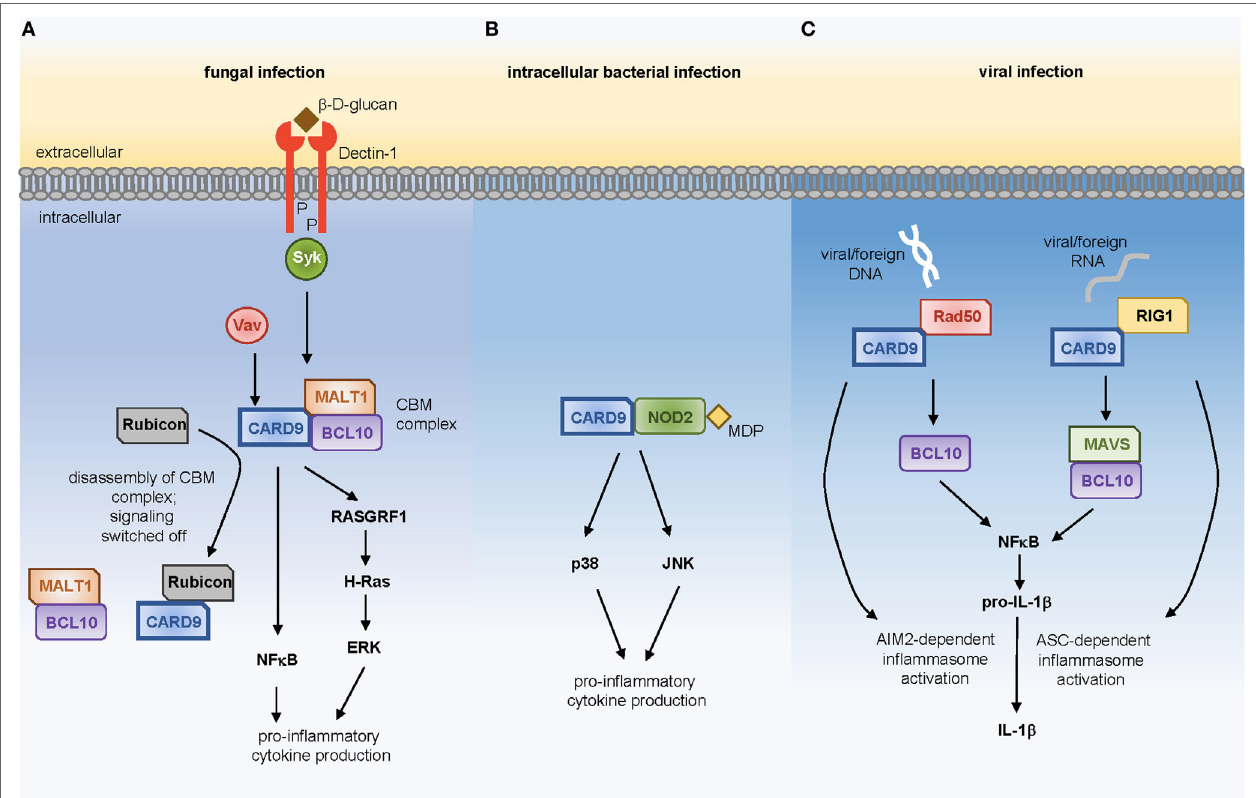
FigURe 1 | CARD9-dependent signaling in response to (A) fungal ligands via Dectin-1, (B) muramyl-dipeptide derived from intracellular bacterial pathogens, or (C) viral DNA or RNA.